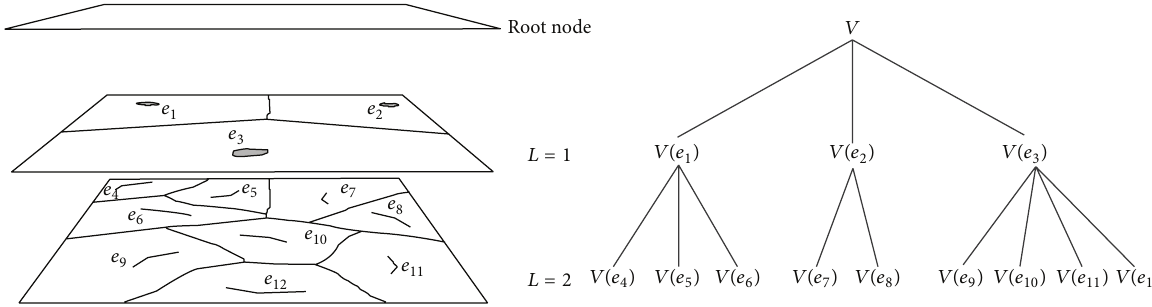
Figure 1: An SVT and its corresponding